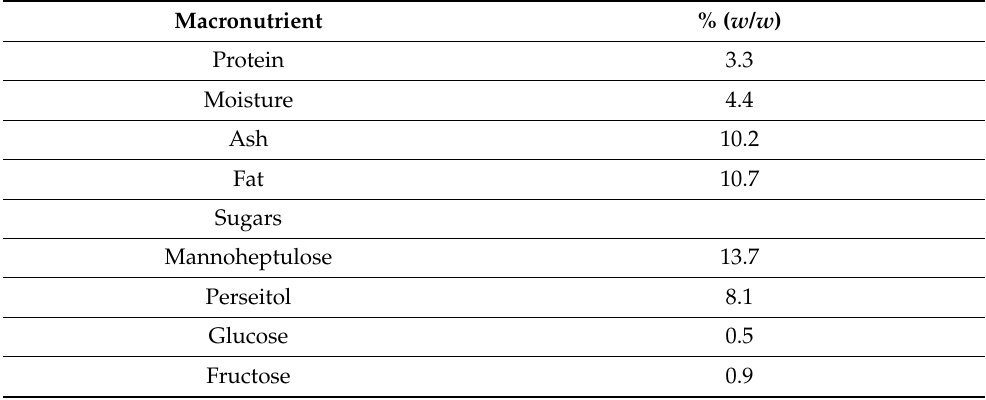
Table 1. Macronutrient Content of Avocado Extract